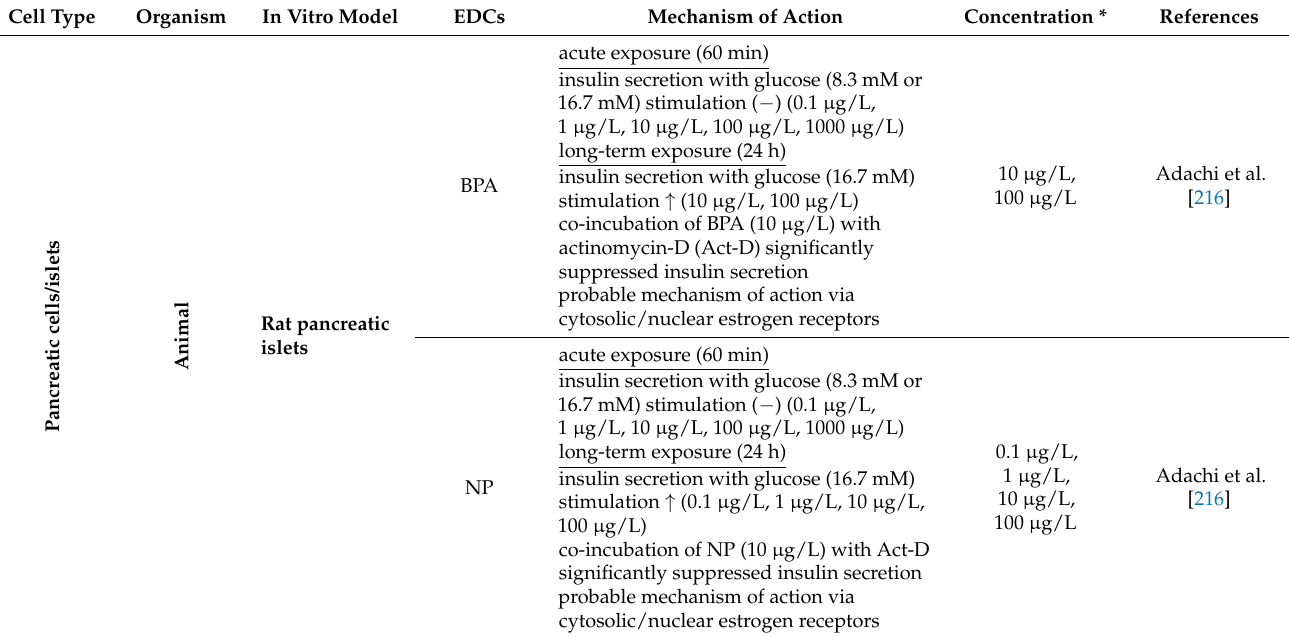
Table 4. The obesogenic effect of selected EDCs confirmed on pancreatic cellular